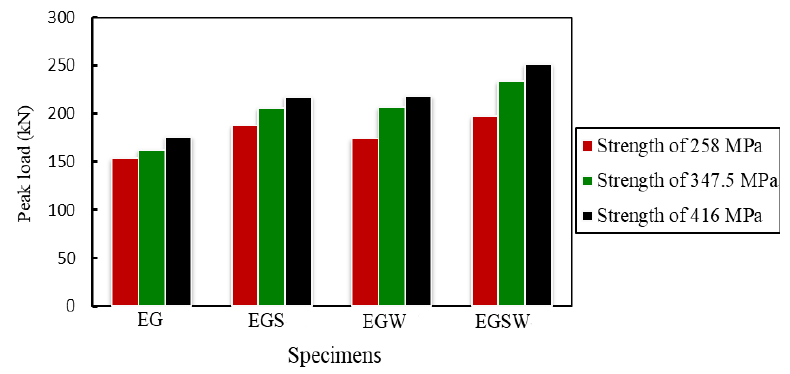
Figure 17. The variation of the peak is loads based on the GFRP tensile strength.